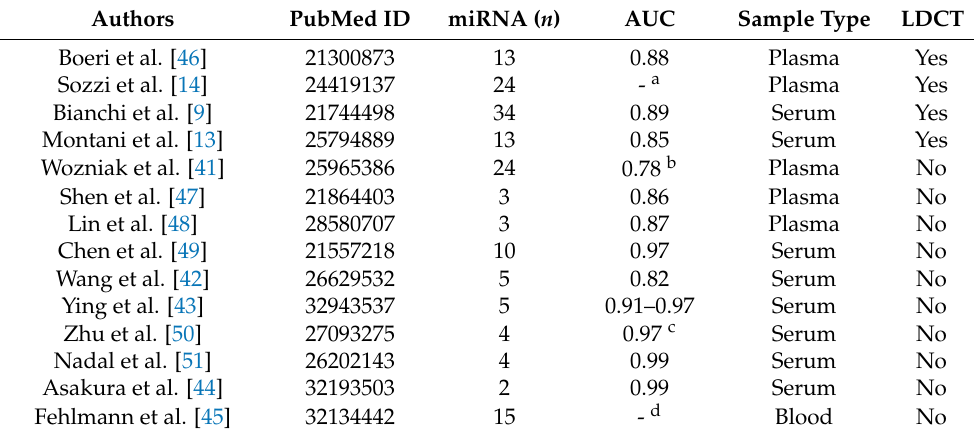
The number of miRNA ( n ) in each diagnostic signature is reported together with the performance (AUC, i.e., area under curve) and the type of biospecimen where biomarkers were derived (Serum or Plasma). LDCT, studies which performed validation of biomarkers on actual LD-CT screening trials (Yes). a Sensitivity, 88% and a specificity of 80%; b Predicted performance when applied to independent samples. c miRNAs combined with carcinoembryonic antigen (CEA). d Sensitivity, 82.8%, and a specificity of 93.5%. PubMed identifiers (PubMed ID) are reported to allow retrieving cited